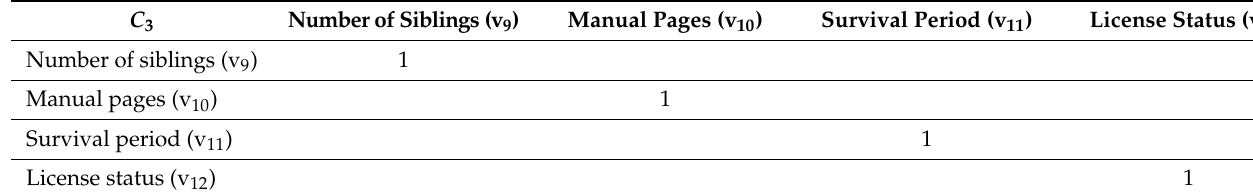
Table A4. Judgment of the importance of legal value indicators.